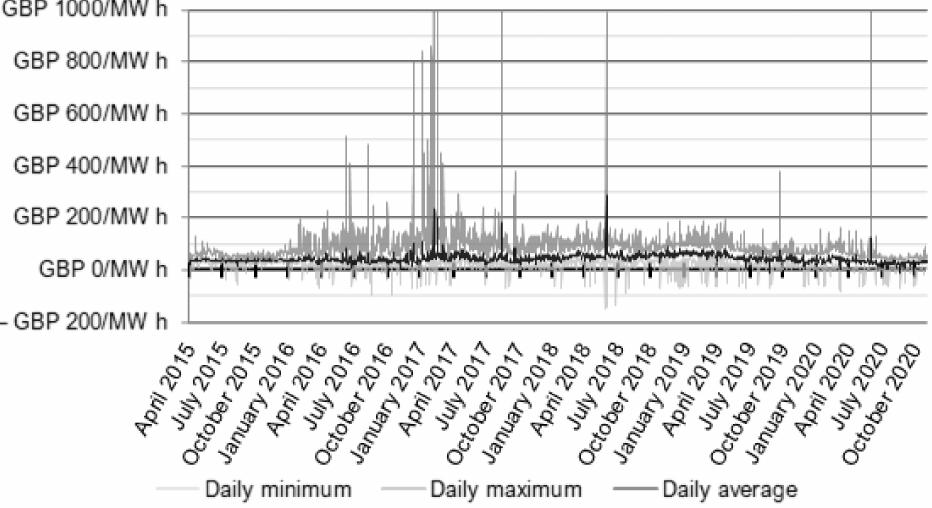
Figure 1. BM daily prices’ average ranging from 1 April 2015 to 31 October 2020. Data source: [55]. PAR500 period ended in November 2015, PAR50 period ended in November 2018. In isolated instances, the price was higher than GBP 1000.00/MW · h, reaching GBP 1528.72/MW · h in February 2017, GBP 1509.80/MW · h in August 2017 and GBP 2242.31/MW · h in June